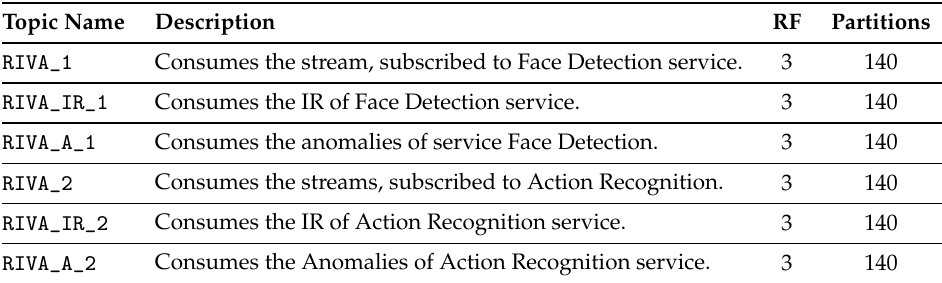
Table 1. Topics for Face Detection and Action Recognition